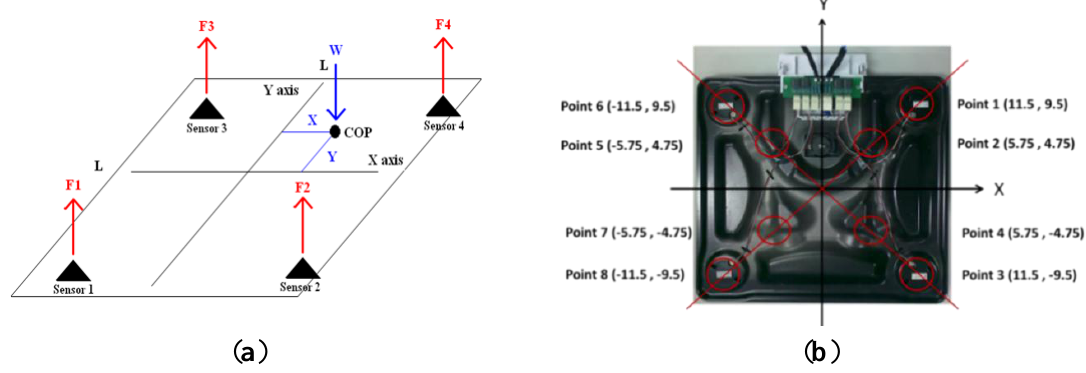
Figure 3. ( a ) The schematic diagram for calculating the COP location. ( b ) The schematic diagram of eight test locations.